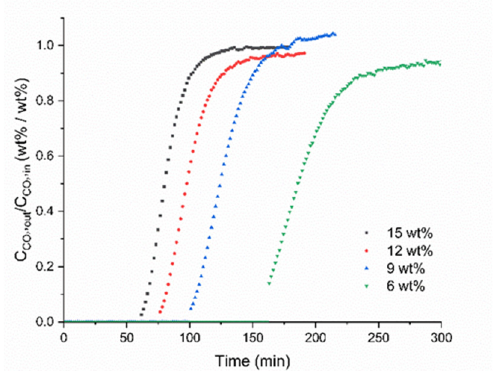
Figure 5. CO 2 sorption properties of porous PAMAM hydrogel particles ( P-M 1 . 5 A 1400 T 0 . 6 -2L ) with various CO 2 concentrations of input gas.